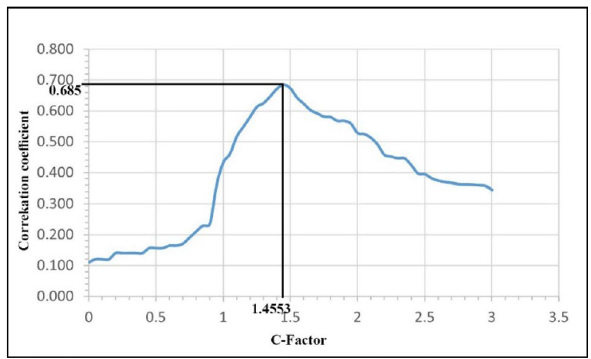
Figure 4. Rotation factor “c” estimation from the Target correlation coefficient analysis.